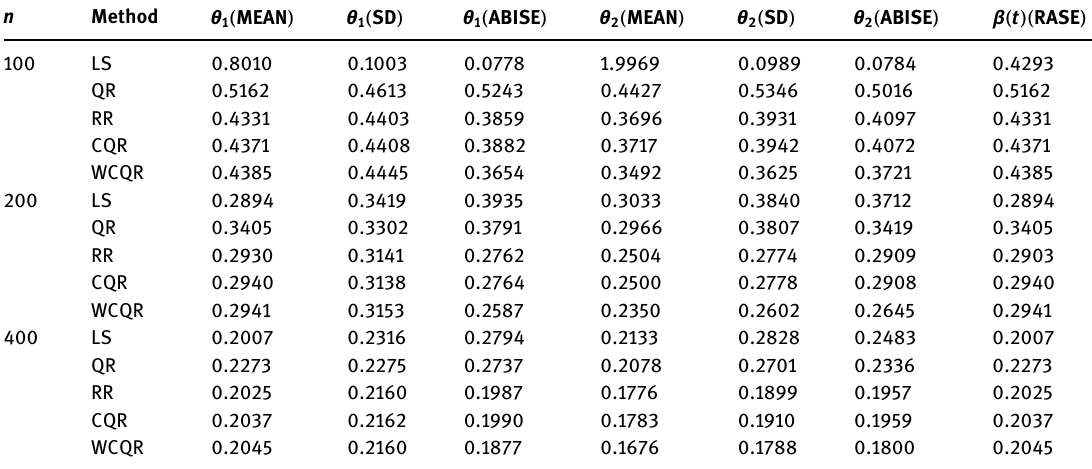
Table 1: Simulation results for θ with N ( 0, 1 ) random error